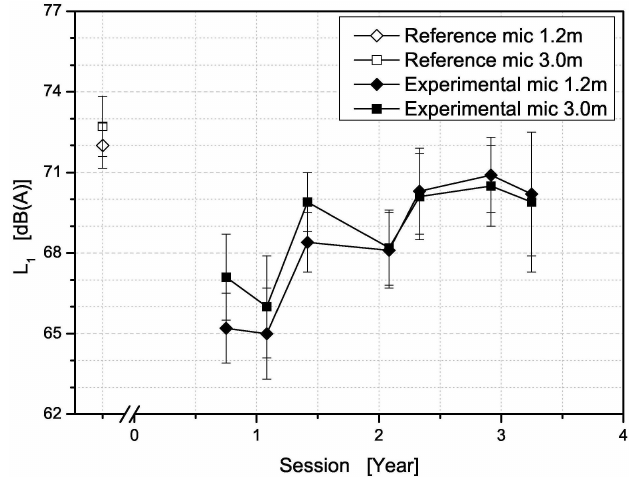
Figure 6. Absolute ( a ) and differential ( b ) values of L (e.g., time, in years) for the SMA optimized texture surface laid in Site 2.